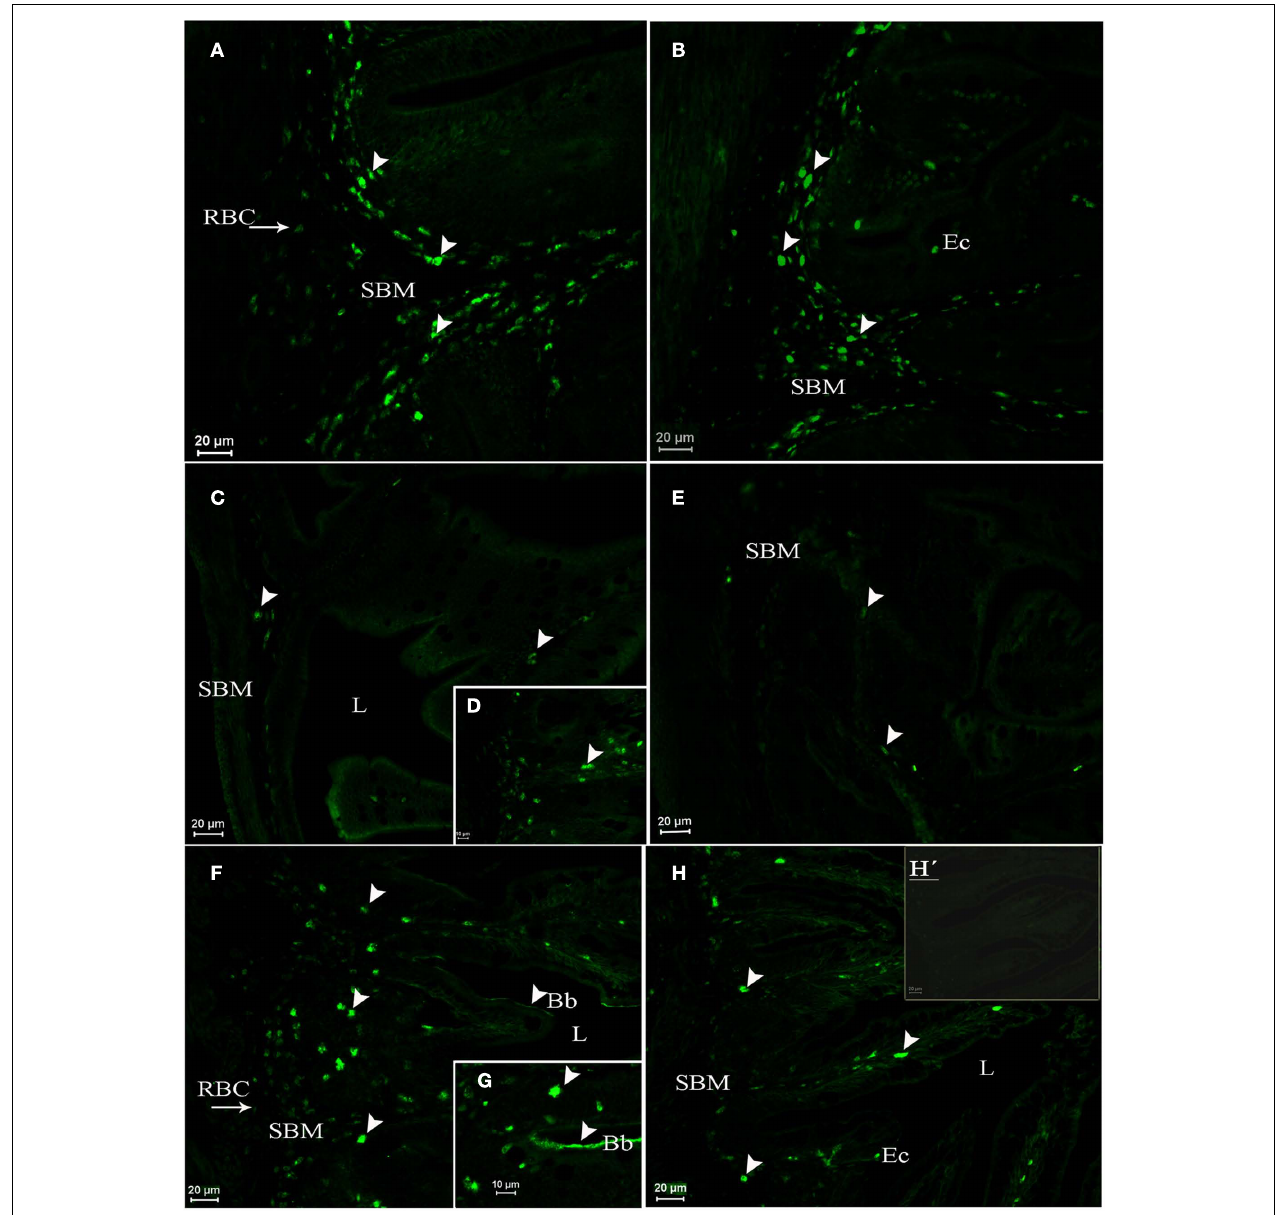
cells (Ec). Immunoreaction for AQP1a in the apical brush border cells (Bb) was stronger in the rectum of SW-acclimated fish than in FW-acclimated fish. Bb, brush border; Ec, epithelial cells; L, lumen; RBC, red blood cell; SBM, submucosa; SW, sea water; FW, fresh water. H (cid:2) is a negative control without primary